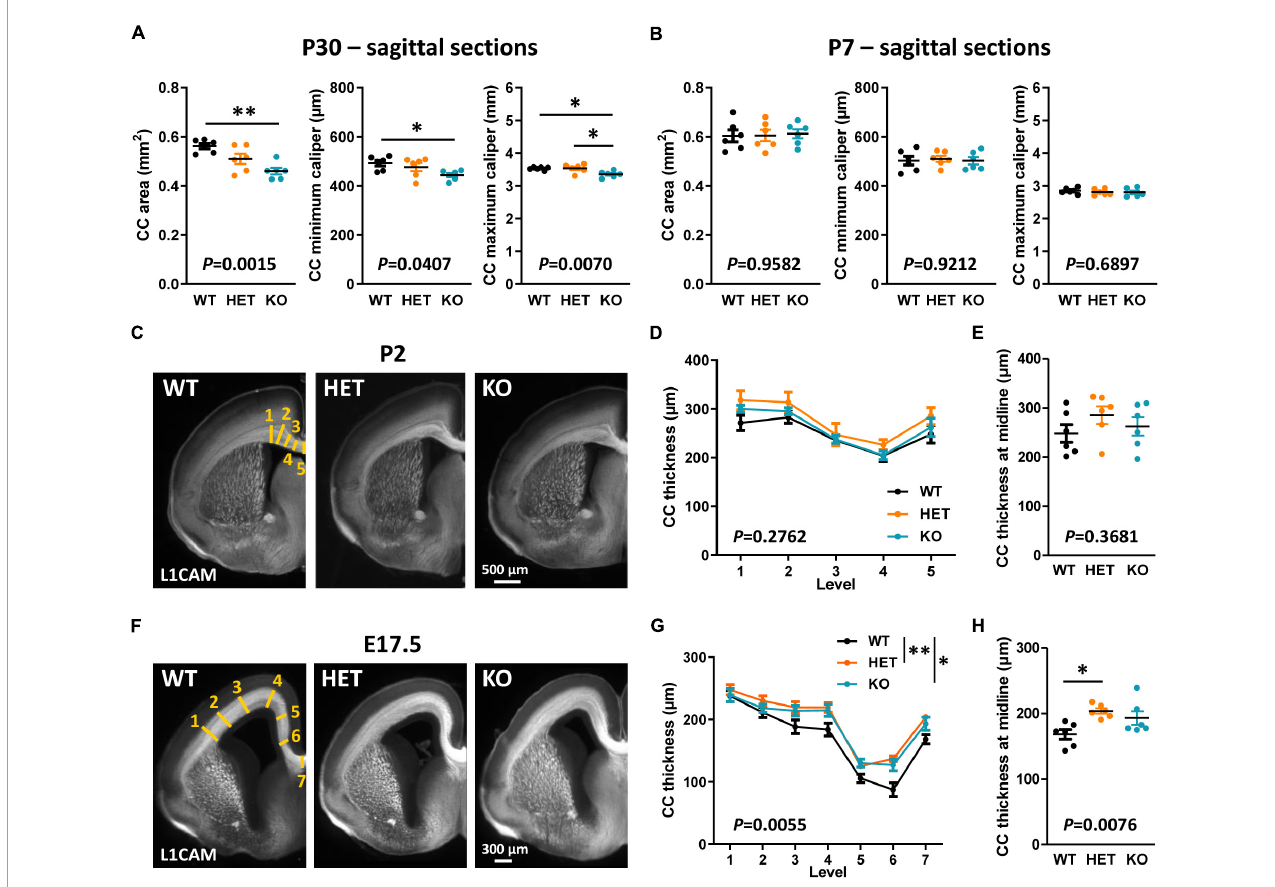
FIGURE2 Corpus callosum (CC) morphology during development. CC area, minimum caliper, and maximum caliper measured on mid-sagittal brain sections of wild-type (WT), HET, and KO P30 mice (A) and P7 pups (B) . Representative images of brain coronal sections of WT, HET, and KO P2 pups (C) and E17.5 embryos (F) showing CC immunostained with anti-L1-CAM antibodies; the levels where CC thickness measurements were performed are schematized on the images of WT mice (yellow lines). CC thickness measured on coronal sections of P2 pups (D) and E17.5 embryos (G) at the levels indicated in panels (C,F) . CC thickness at the midline of the brains of P2 pups (E) and E17.5 embryos (H) . (A,B,D,E,G,H) Six animals/genotype, (A,B) average of measurements on three consecutive sections/animal, (D,G) average of measurements on both hemispheres on one section/animal, (E,H) measurements on one section/animal. Statistical tests: Unpaired t -test (A,B,E) or Mann–Whitney test (H) to compare HET or KO mice to WT mice, and one-way ANOVA test (A,B,E) or Kruskal–Wallis test (H) to compare the three genotypes; (D,G) Two-way RM ANOVA test followed by a Tukey’s multiple comparisons test (G) ; ∗ P < 0.05, ∗∗ P <